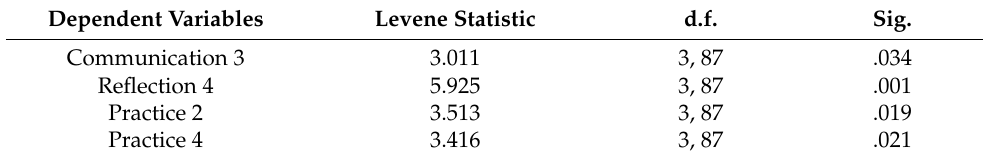
Table 5. Results of the Test of Homogeneity of Variance.